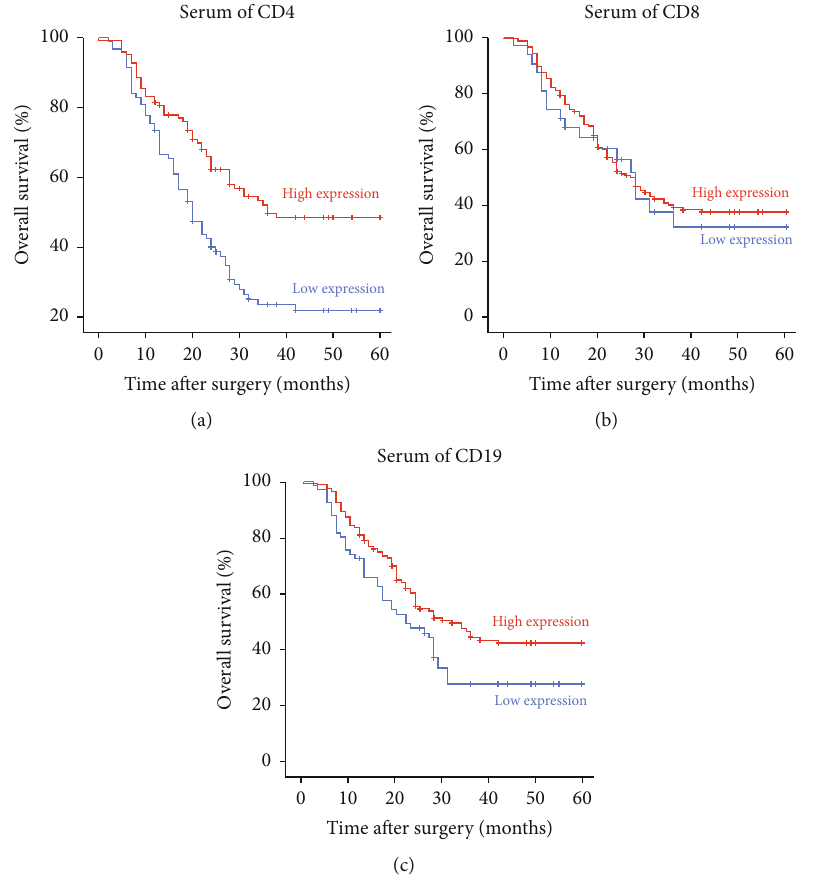
Figure 1: Overall survival of patients with GC strati fi ed by the systemic in fl ammatory markers CD4, CD8, and